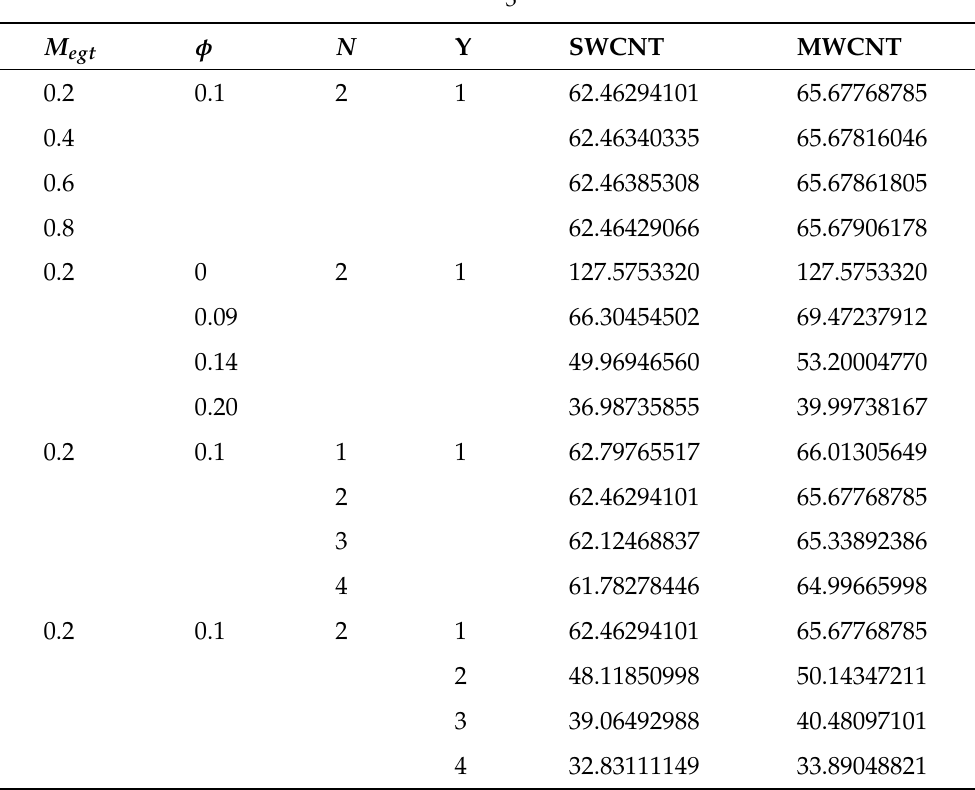
Table 3. The value table of − θ (cid:48) ( 0 ) with κ = 1, ω =